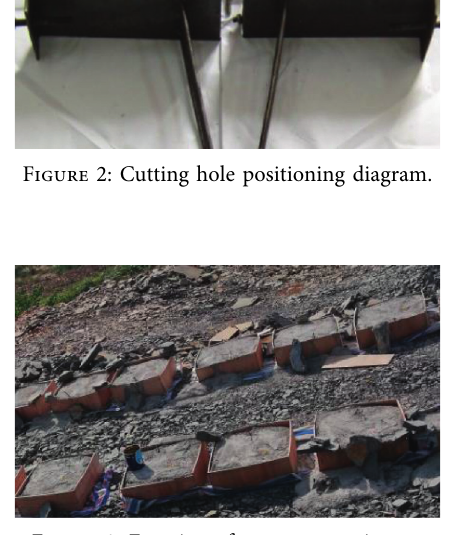
Figure 3: Forming of concrete